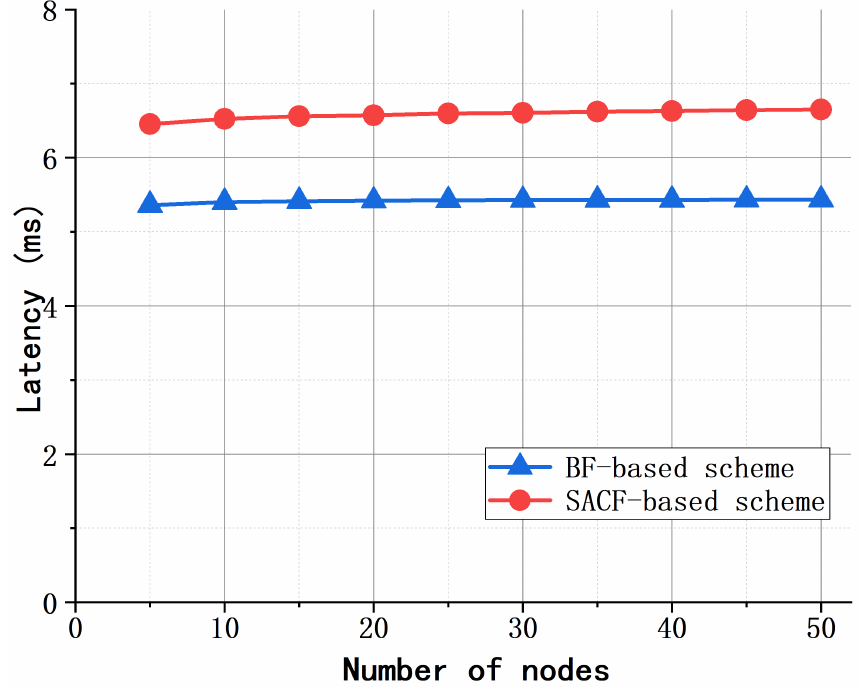
Figure 10. Forwarding latency under varied network sizes.